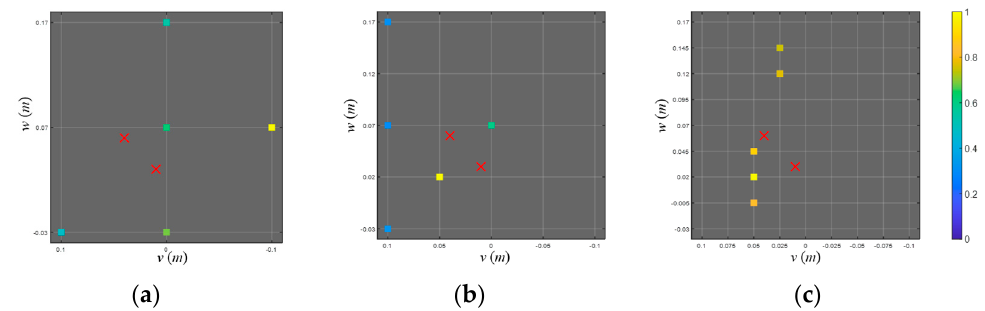
Figure 7. ( a – c ) Localization results using on-grid BSBL with grid intervals 0.10 m, 0.05 m, and 0.25 m. The five largest components (marked with colored squares) and two sources (marked with ‘x’) are projected onto the v–w (looking from the stern side) planes, and each case involves a modeling error owing to basis mismatch. Computational times measured from the localization process were